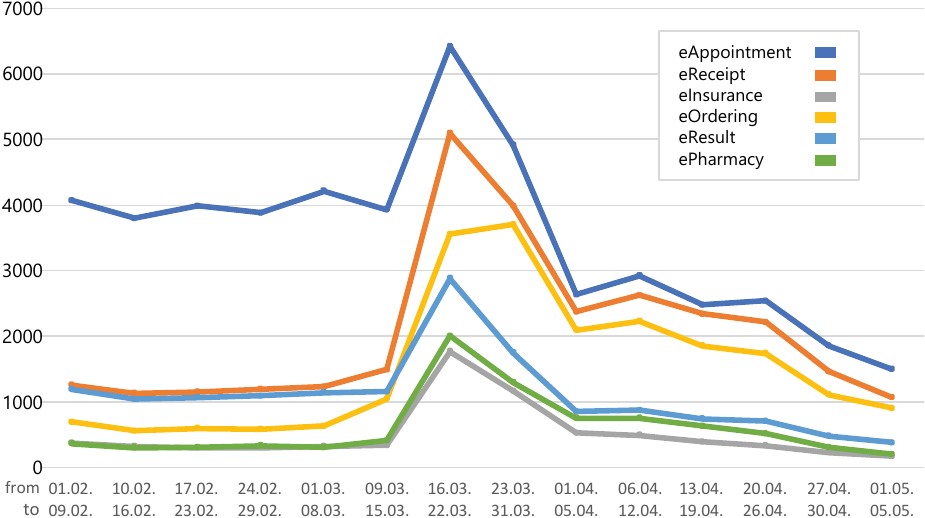
Figure 4. The number of visits for all eServices in Montenegro in